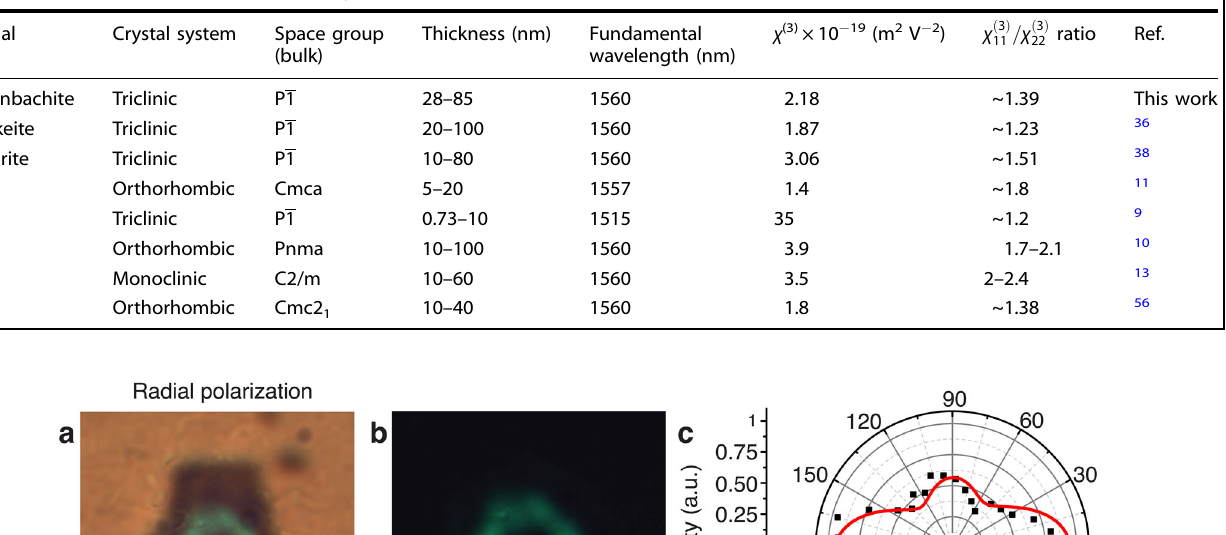
Table 3. Comparison of THG response in lengenbachite with other anisotropic nonlinear 2D materials.